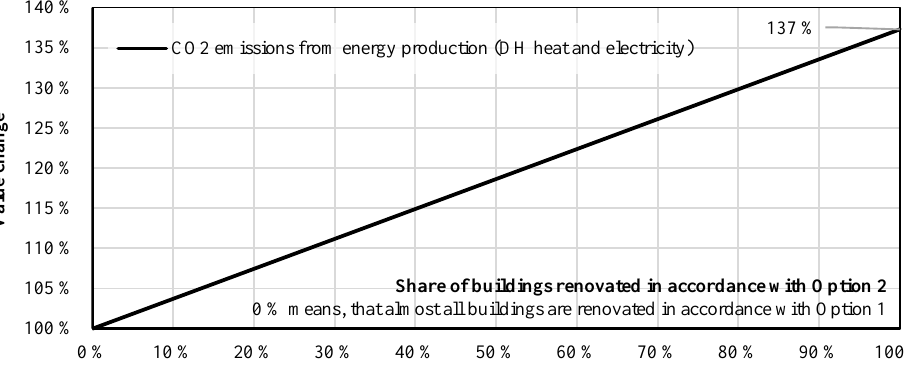
Fig. 4. Impact of an increased share of Option 2 building renovation solution implementation on CO 2 emissions from energy production (DH heat and